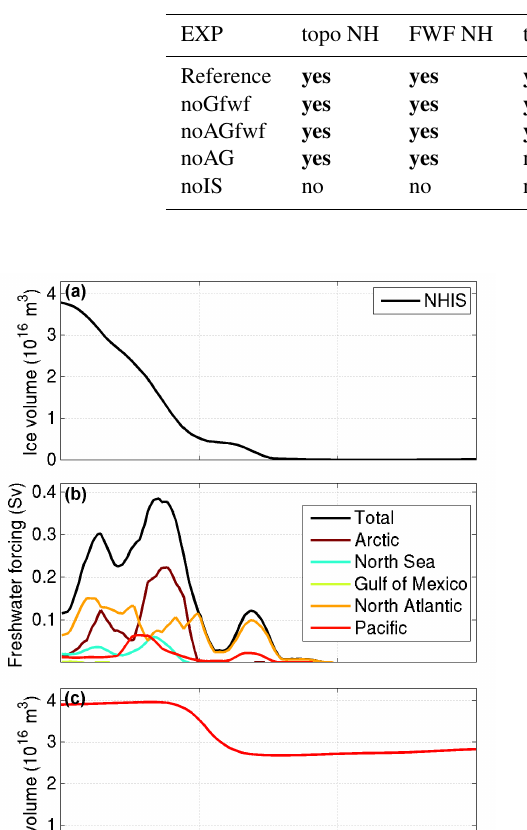
Table 1. Matrix of all experiments and the respective ice sheet components that evolve in time (yes) or are fixed (no). In the latter case, freshwater fluxes (FWF, bold) are kept constant and topography and surface albedo are fixed to the pre-industrial configuration.